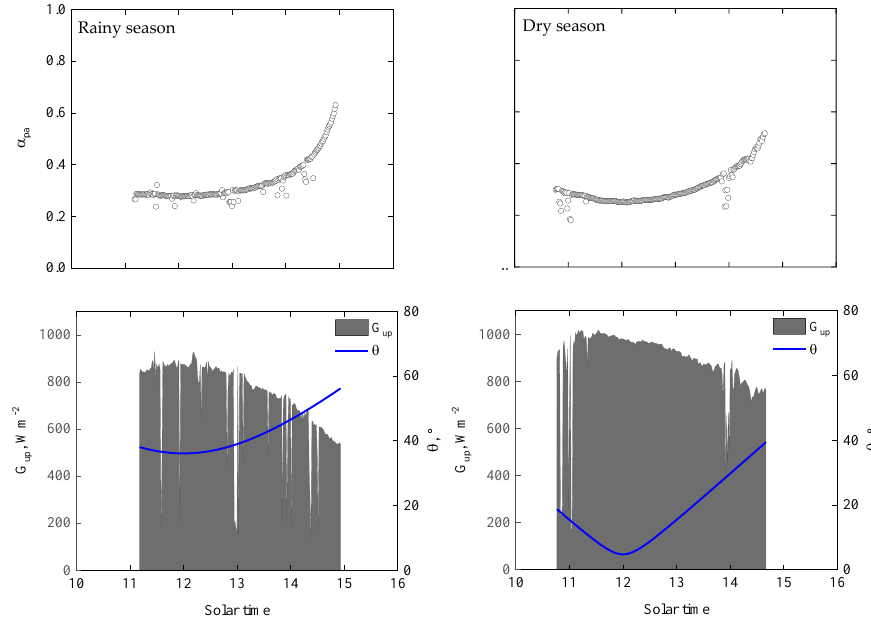
Figure 6. Total solar radiation G up , zenith angle θ, and albedo of paddy rice α during the rainy season (19 November 2012) and the dry season (15 April 2013) at IRRI in Los Baños, Republic of the Philippines (14°9 ′ 55 ′′ N, 121°15 ′ 37 ′′